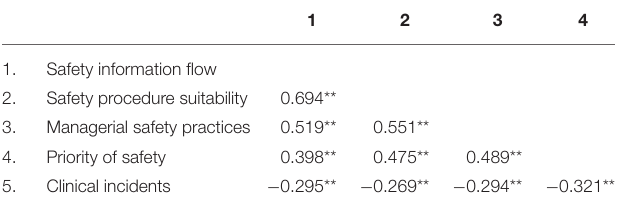
TABLE 2 | The correlation matrix (** p ≤ 0.01, * p ≤ 0.05). TABLE 4 | Findings from mediation